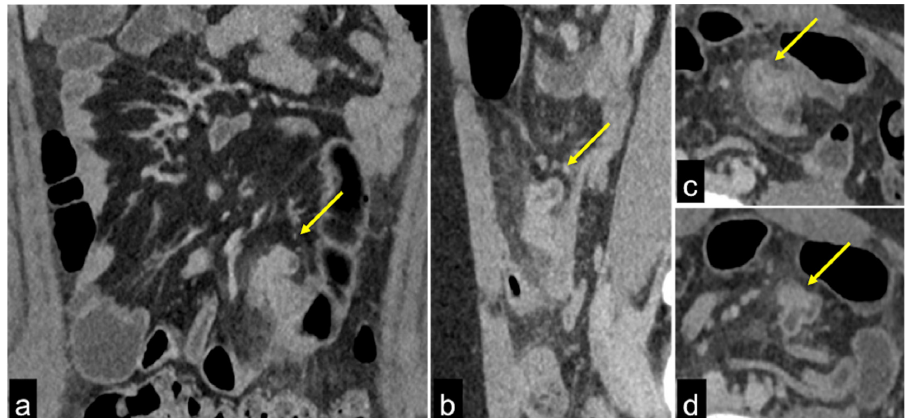
Figure 30. Fifteen-year-old patient complaining of abdominal pain and anaemia. Enhanced CTA scan in portal venous phase in coronal ( a ), sagittal ( b ), axial ( c , d ) views. In the mesogastric region, there is a diverticular ileal structure (( a – d ) arrows) with increased wall enhancement at CTA venous phase, associated with adjacent fat stranding. Findings are consistent with Meckel diverticulitis.